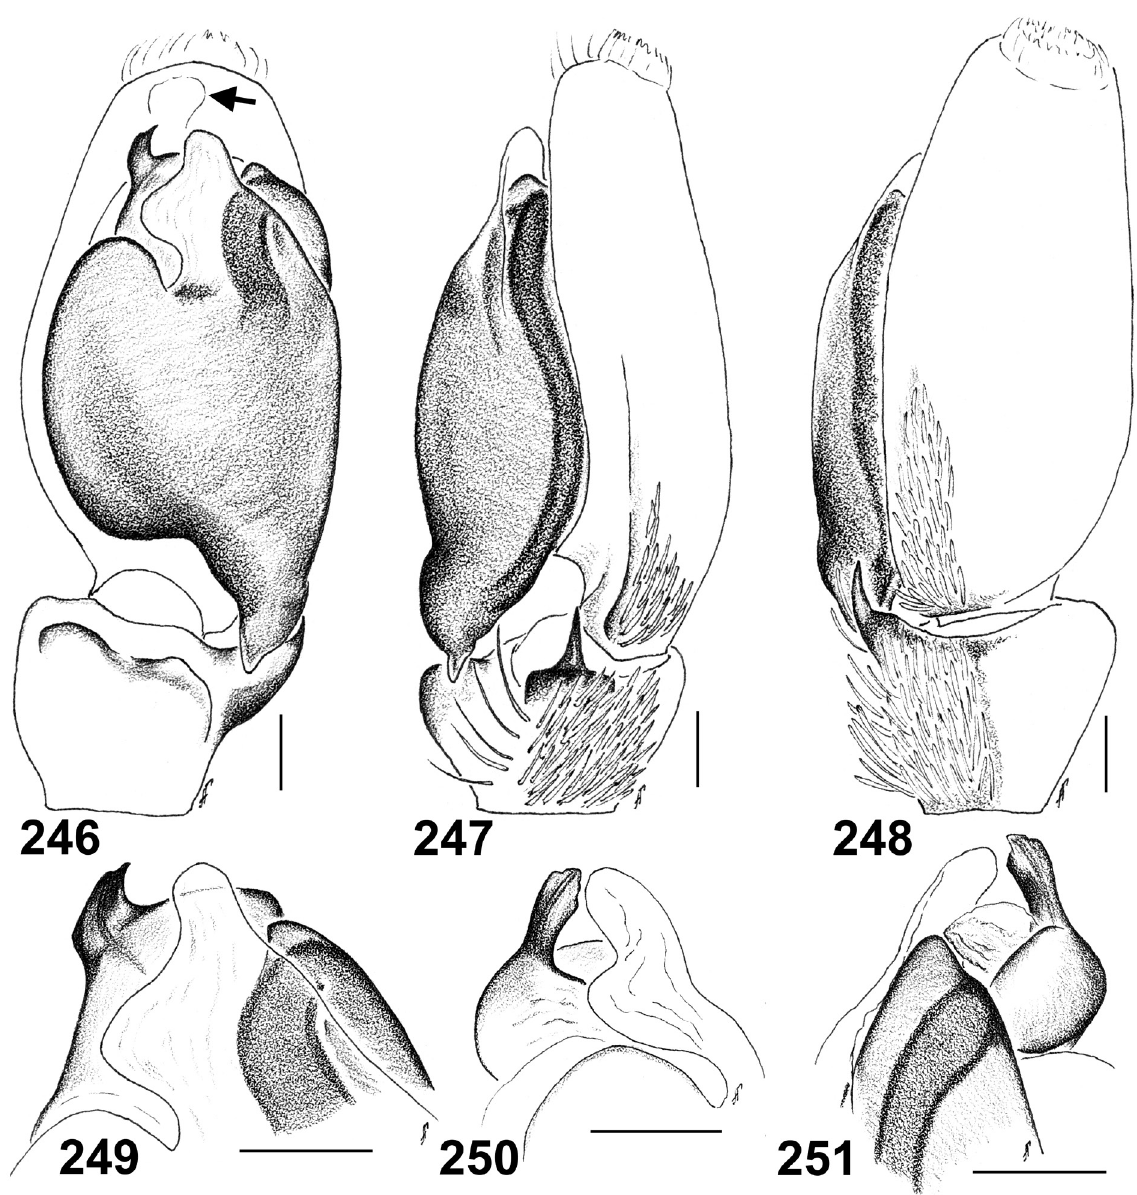
Figs 246–251. Stenaelurillus hirsutus Lessert, 1927 (holotype of Stenaelurillus cristatus Wesołowska & Russell-Smith, 2000). 246 . Male palp, ventral view. 247 . Male palp, retrolateral view. 248 . Male palp, dorsal view. 249 . Embolic division, ventral view. 250 . Embolic division, median view. 251 . Embolic division, retrolateral view. Scale bars: